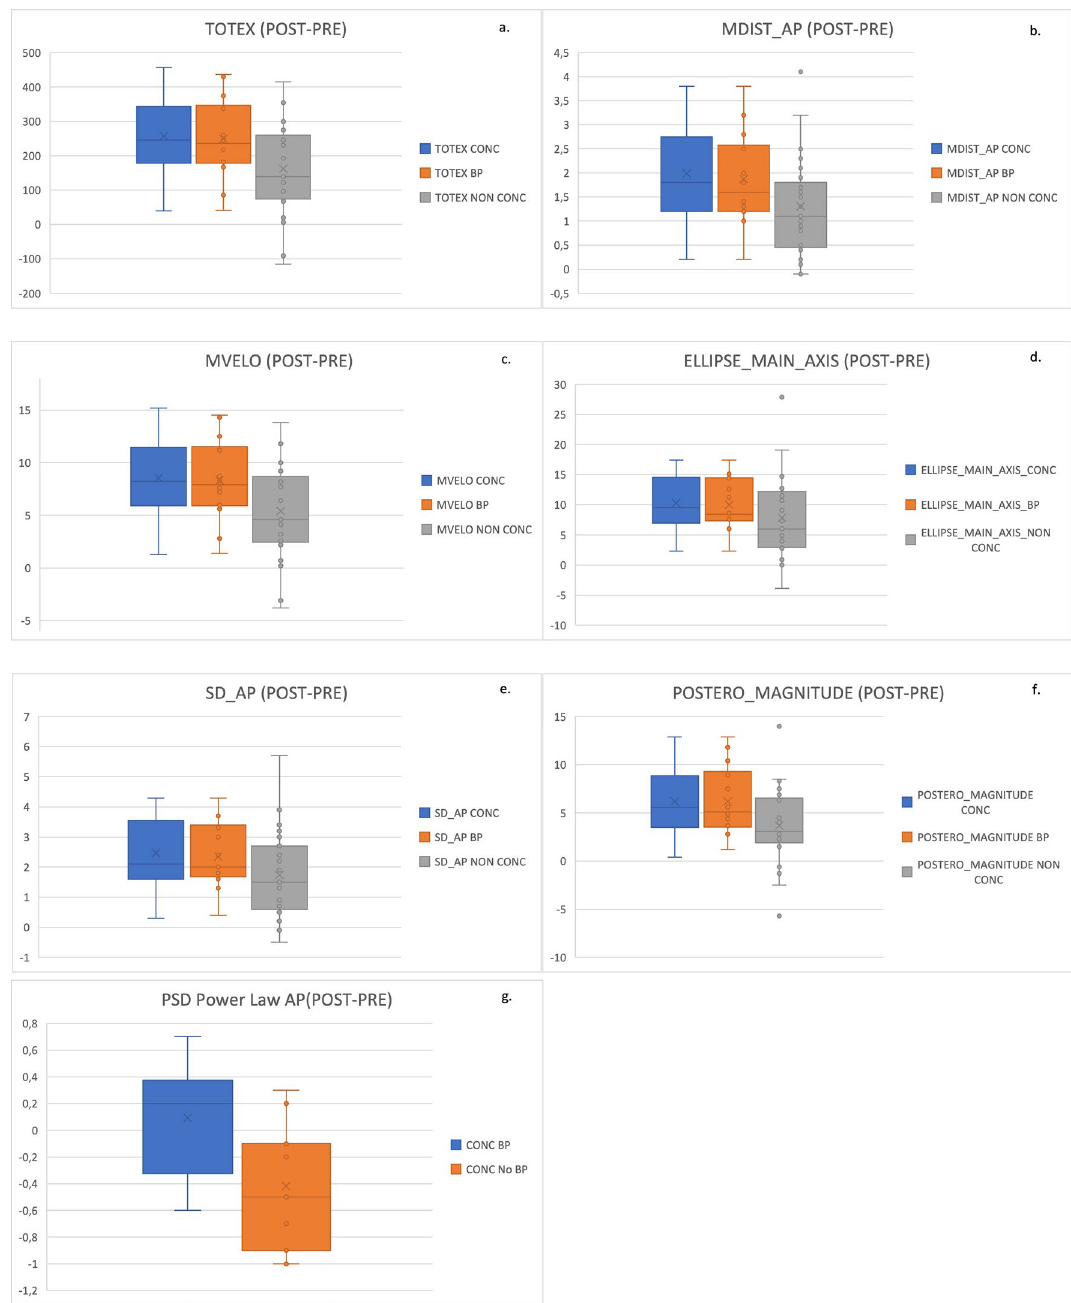
Figure 3. The most statistically significant features computed for the CoP parameters. All groups (Concussion (CONC—blue), Non-concussion (NON CONC—grey) and Balance Problems (BP—orange) showed a statistically significant change from the PRE to the POST stage for TOTEX (Total Excursion), MDIST_AP (Mean distance from centre in antero-posterior direction), MVELO (Mean velocity), ELLIPSE_MAIN_AXIS— The length of the main axis of 95% confidence ellipse, SD_AP (Standard Deviation in antero-posterior direction), POSTERO_MAGNITUDE (Posterior extreme point distance). One spectral feature PSD_EXP_AP— Power Spectral Density (PSD) Power Law is also